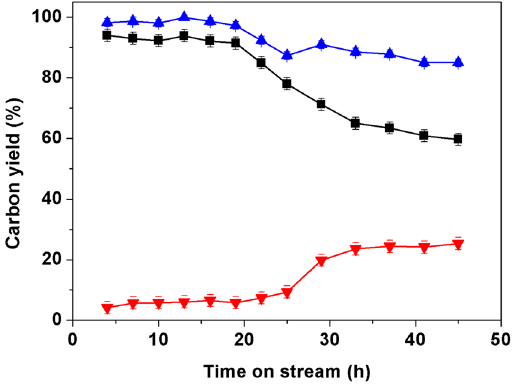
Figure 7. Carbon yields of compound 5 ( ■ ), C 9 -C 17 cycloalkanes ( ) and cycloalkanes ( i.e . the sum of compound 5 and C 9 -C 17 cycloalkanes) ( ), from the solvent-free HDO of compound 4 over the Ni/SiO 2 catalyst as the function of reaction time. Reaction conditions: 573 K, 6.0 MPa H 2 ; 1.80 g Ni/SiO 2 catalyst, compound 4 flow rate: 0.04 mL min − 1 , hydrogen flow rate: 120 mL min − 1